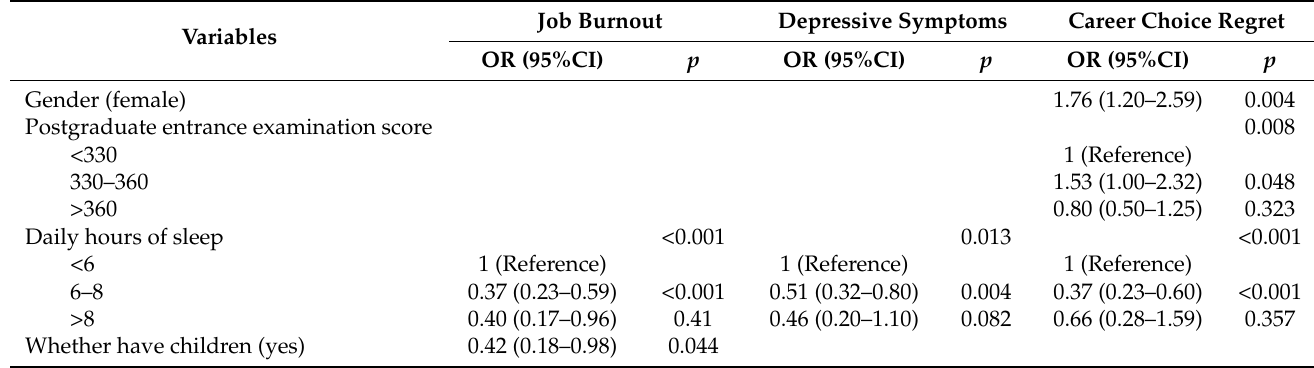
Table 4. Regression model one of job burnout, depressive symptoms, and career choice regret.